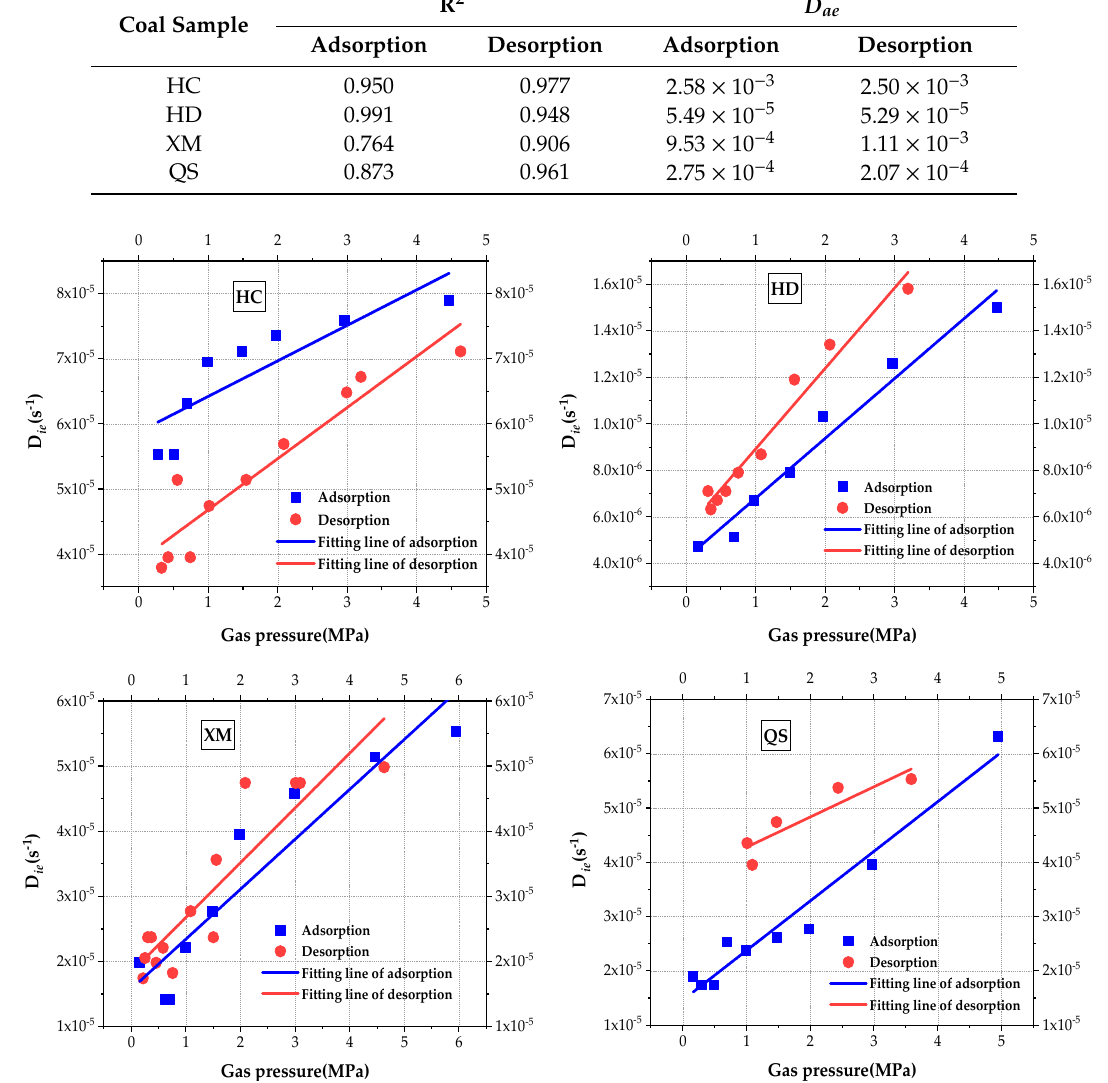
Table 4. Goodness of fit and di ff usion coe ffi cient.